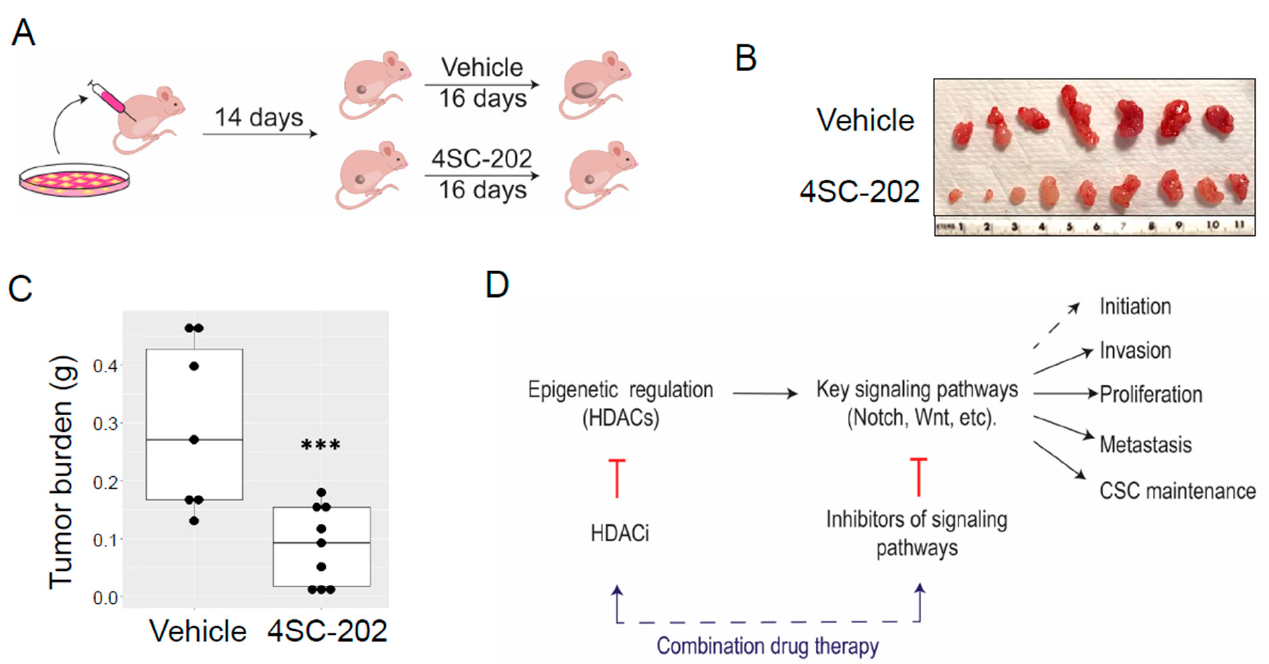
Figure 9. 4SC-202 reduces the tumor growth of SJSA-1 cell in vivo. ( A ) Illustration of in vivo experimental procedure using a xenograft model of nude mice. ( B ) Photographs of SJSA-1 xenografted tumors at harvest from nude mice. ( C ) Quantification of tumor burden of xenografted tumors treated with or without 4SC-202 ( n = 7 for vehicle and n = 9 for 4SC-202 treated mice, *** p < 0.001, data are presented as mean (SD)). ( D ) Proposed future studies on tumor cell behaviors of osteosarcoma.